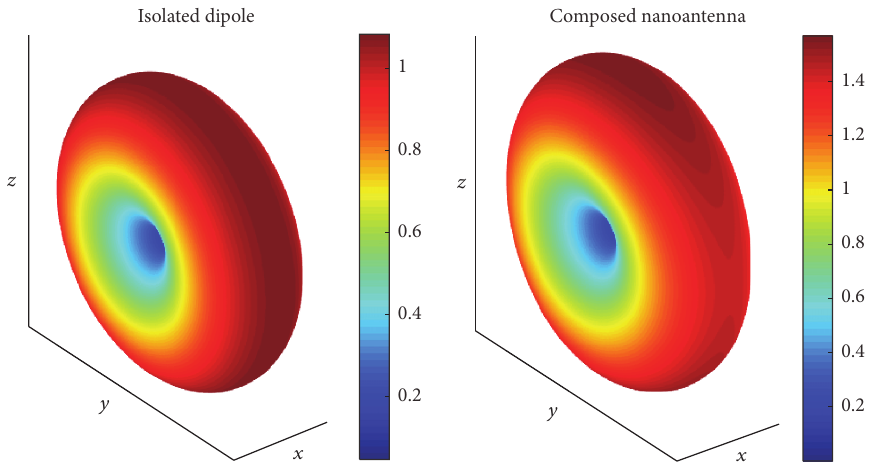
Figure 10: 3D far field gain radiation pattern of the isolated dipole and composed antenna for the central frequencies 194.97 and 170.85 THz, respectively.